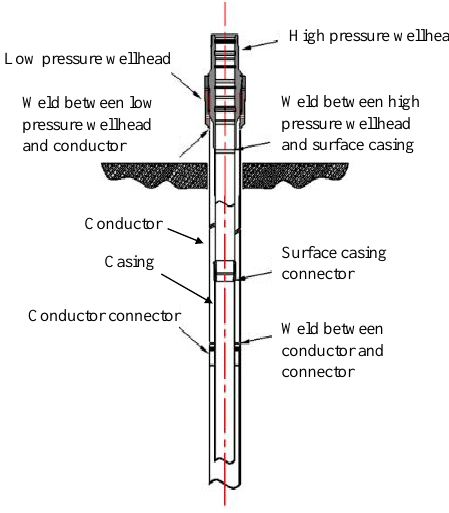
Figure 2. Typical SW system.